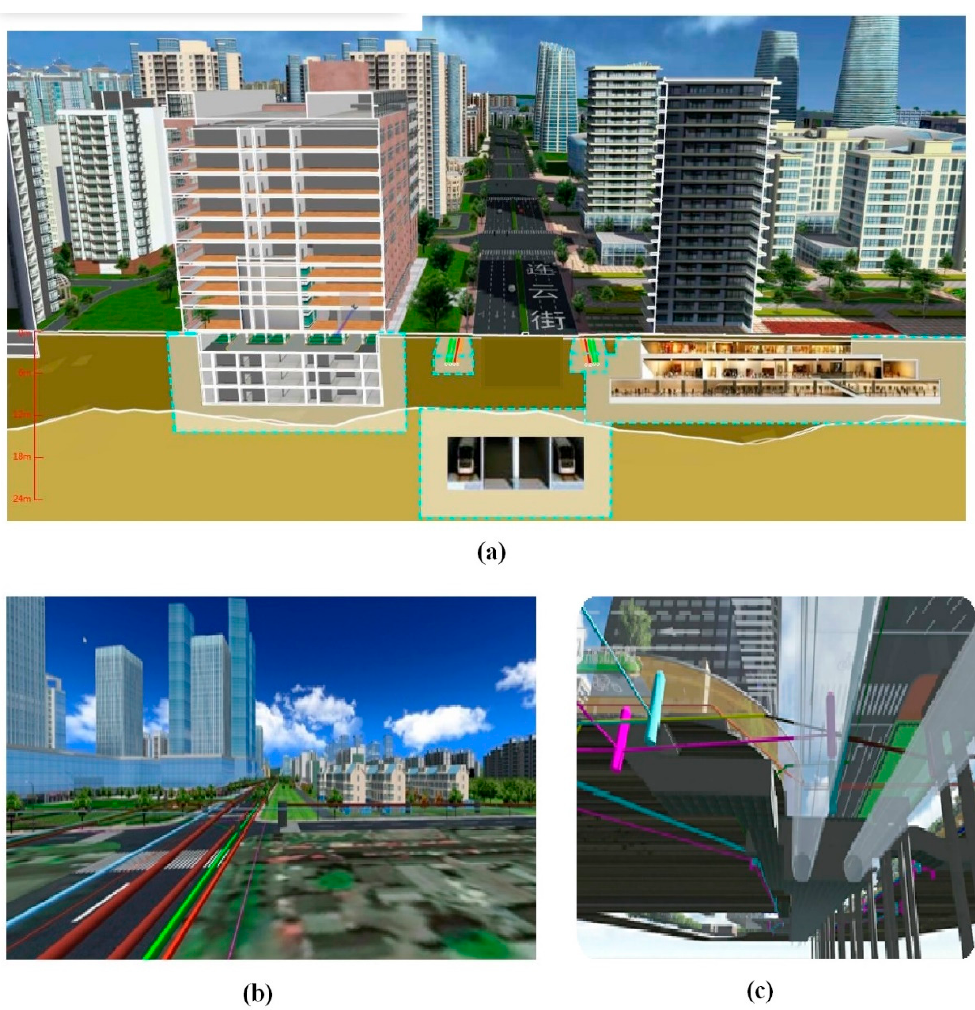
Figure 13. 3D model of the WDS project and its surroundings ( a–c ).